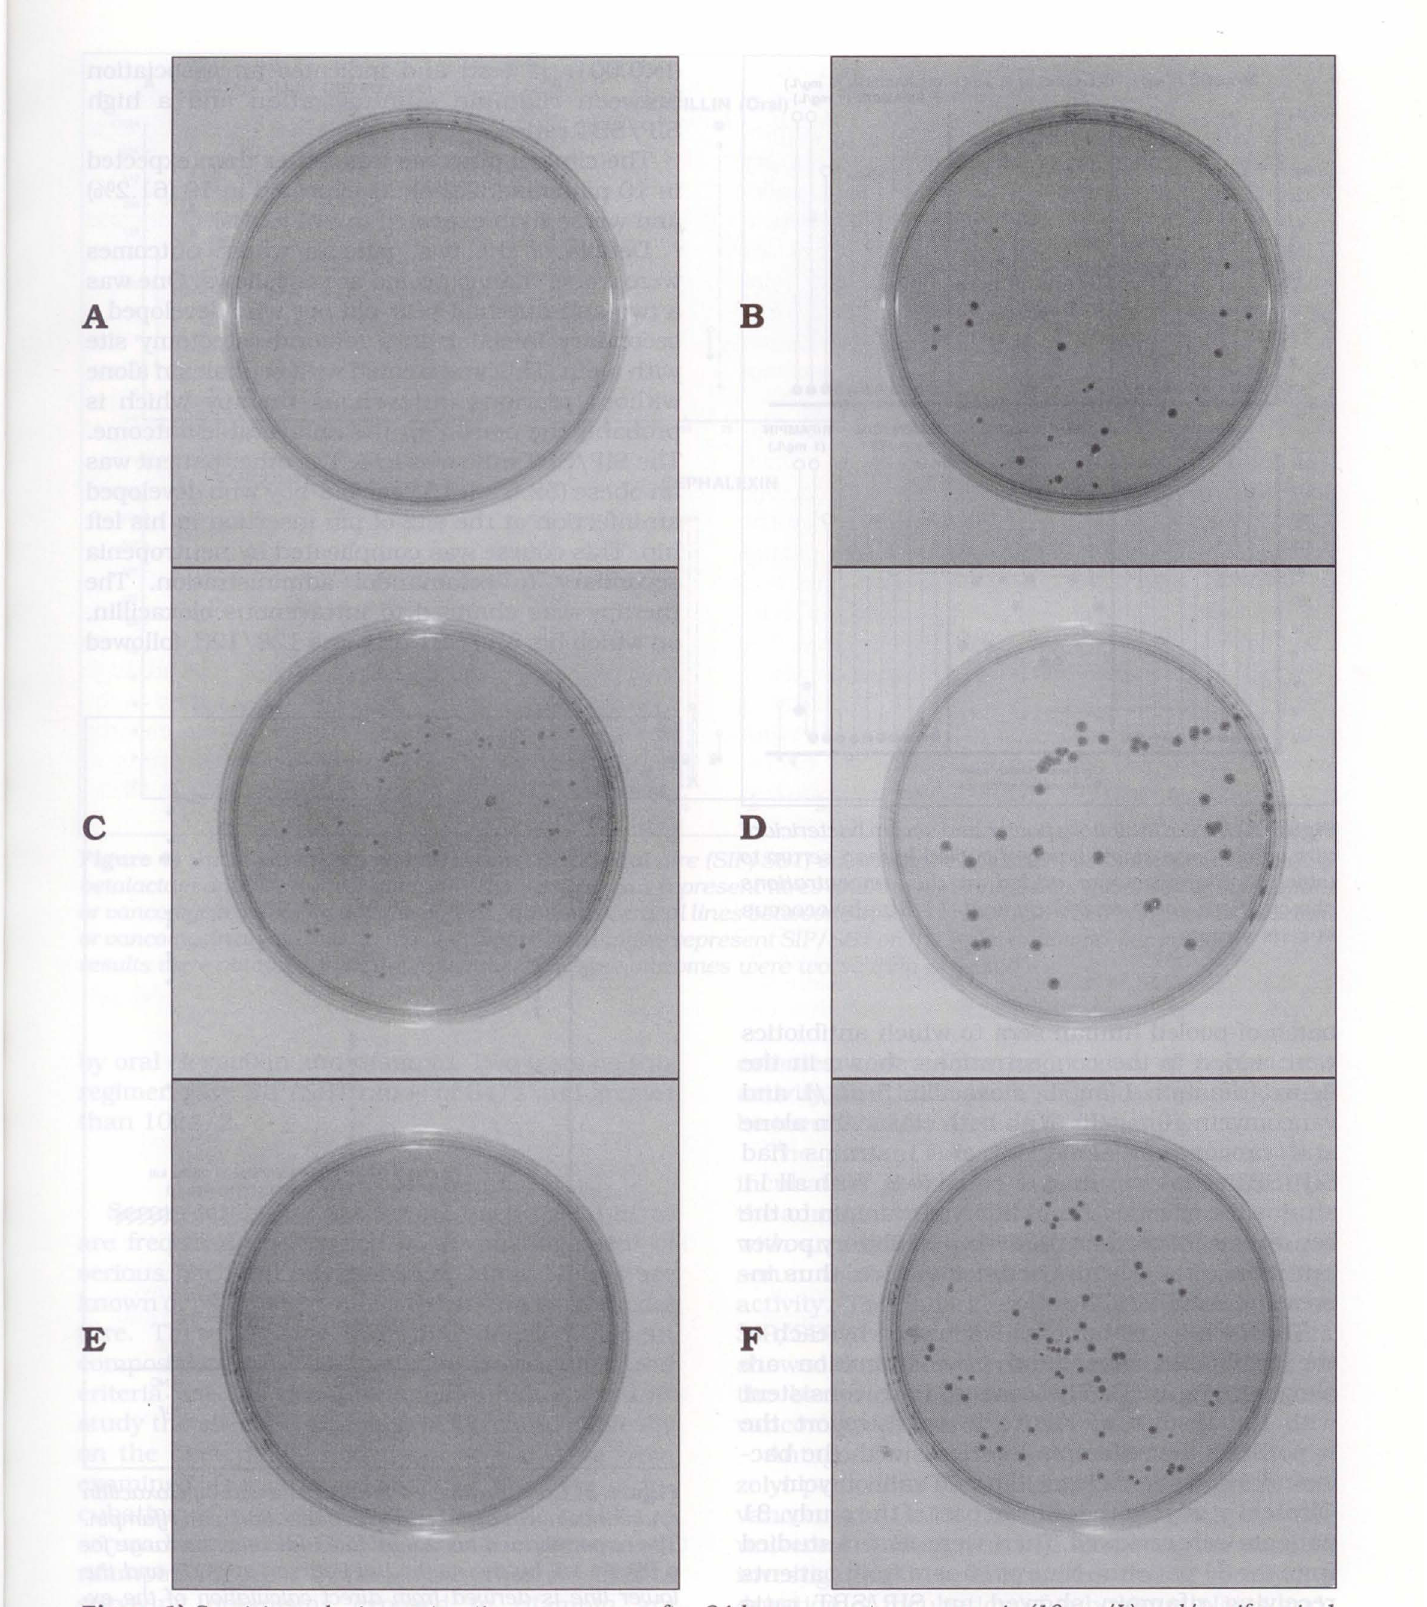
Figure 1) Surviving colonies on trypticase soy agar after 24 h exposure to vancomycin (10 mg/L) and/or rifampin